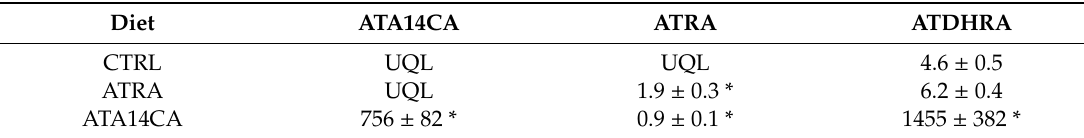
Table 2. Concentrations of retinoids in female mouse serum (each n = 4) of mice supplemented with vehicle (CTRL), and equimolar concentrations of all- trans retinoic acid (ATRA) (50 mg / kg bw) or all- trans -A14C (ATA14CA) (54.3 mg / kg bw) to